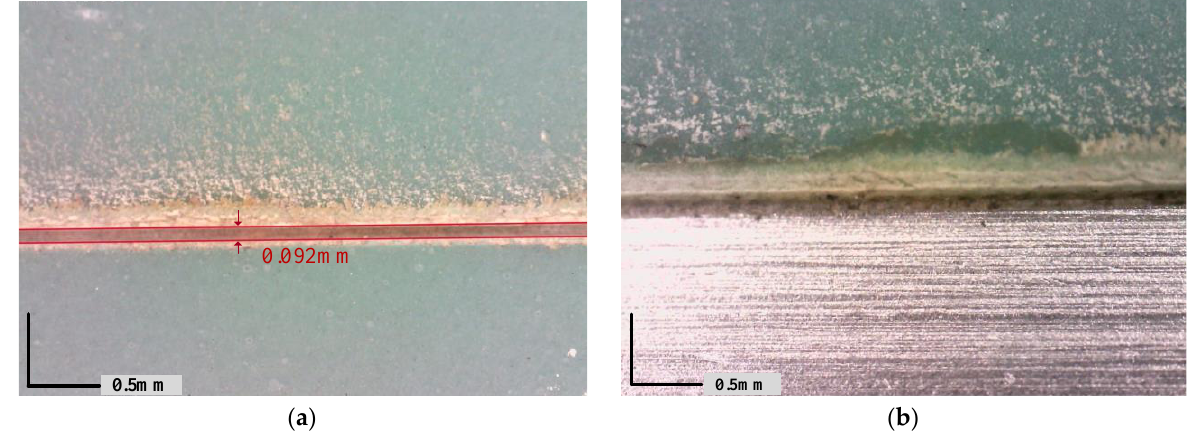
Figure 5. Good quality of laser scribing and stripping. ( a ) Width of laser scribing; ( b ) Edge quality of the laser.